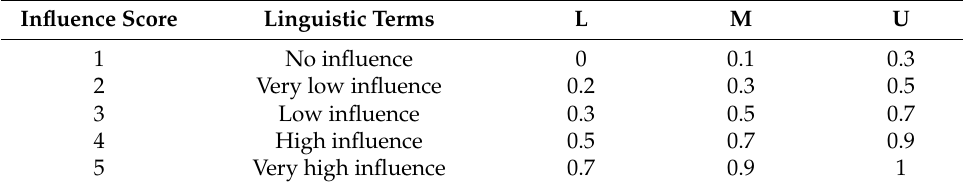
Table 6. Fuzzy-based linguistic scale.